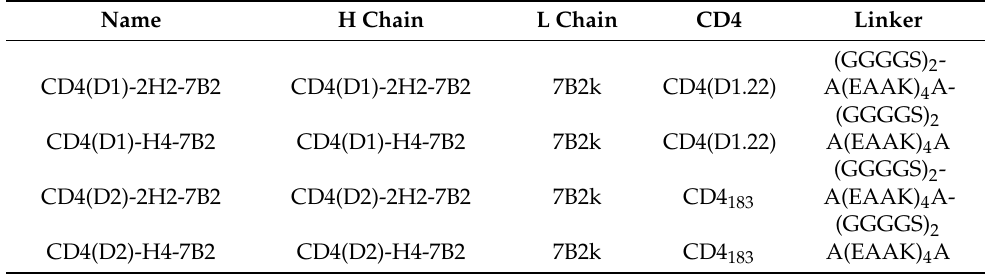
Table 1. Description of CD4-7B2 chimeric